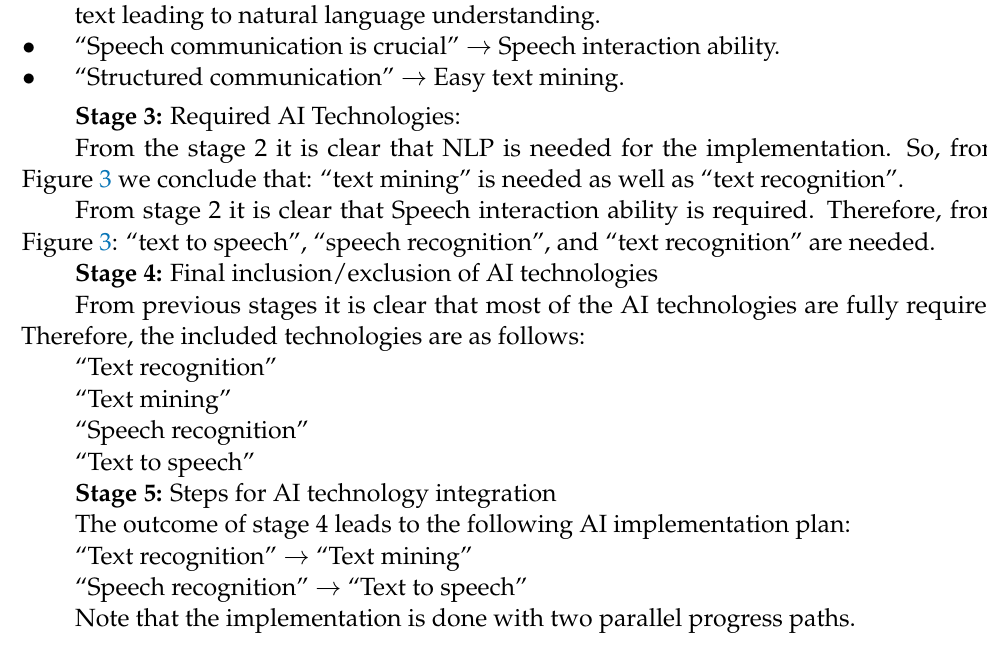
Stage 4: Final inclusion/exclusion of AI